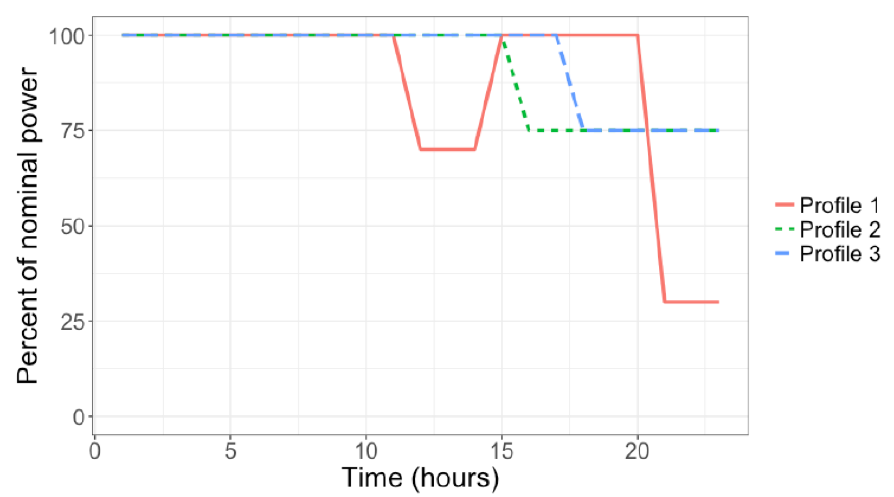
Figure 2. Typical profile operation power manoeuvres